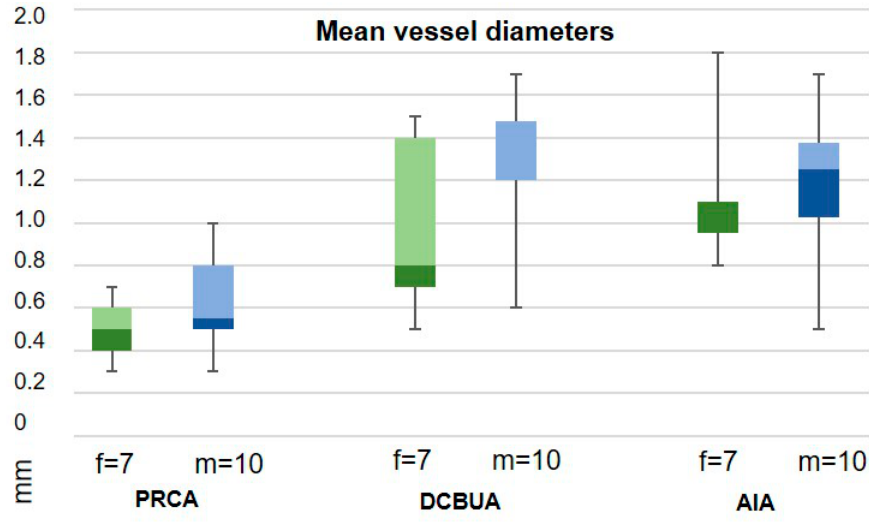
Figure 5. Mean vessel diameters of the palmar radiocarpal arch (PRCA), the dorsal carpal branch of the ulnar artery (DCBUA), and the interosseous artery (AIA) did not di ff er signi fi cantly between men (m) and women (f). Box plots with min/max values, median 25th and 75th percentile.